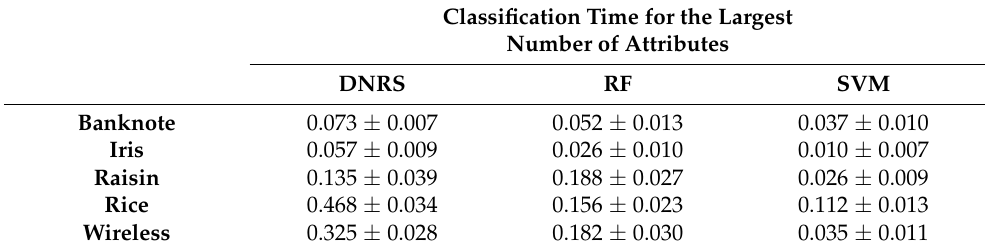
Table 14. Classification time for UCI datasets (in seconds).